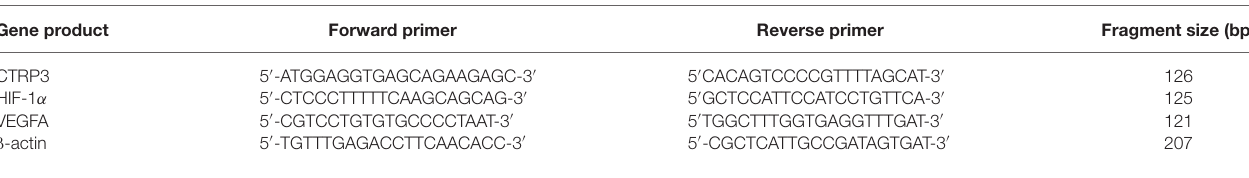
TABLE 1 | Primers used in